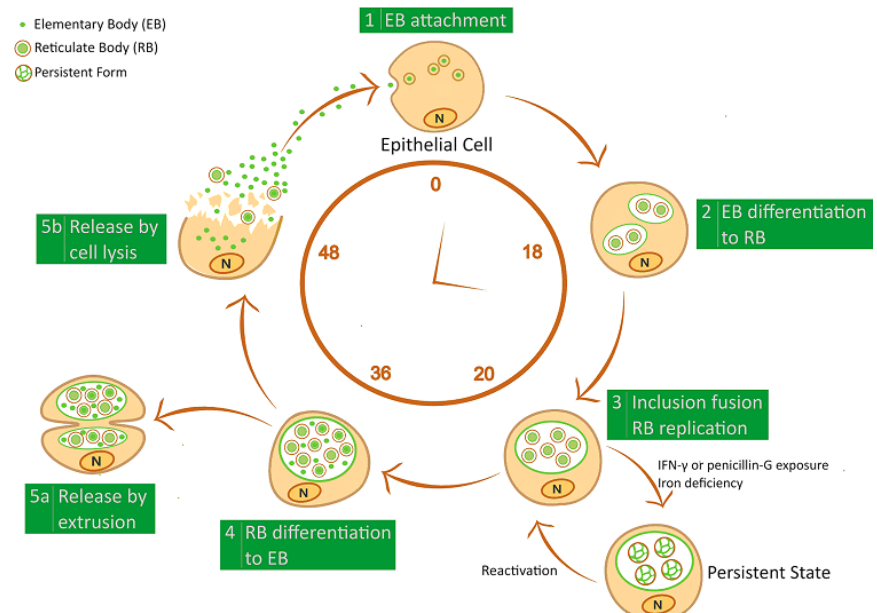
Figure 1. Schematic representation of Chlamydiae developmental cycle. Infectious elementary body (EB) enters into the host-cell and transforms in the replicative reticulate body (RB); RB re-differentiates into EB, which is released from the host-cell by inclusion extrusion or cell lysis. Exposure to IFN- γ and penicillin G or iron depletion induce Chlamydiae to generate a non-infectious persistent form.